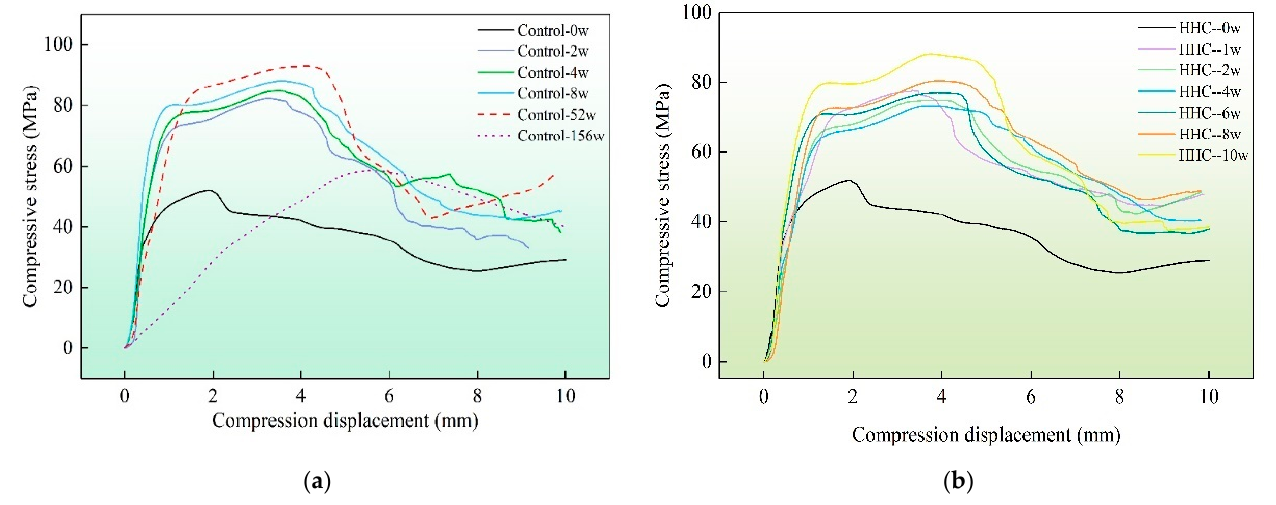
Figure 11. Stress-strain curve during humidity heat ageing and natural ageing. ( a ) Stress-strain curves during storage of control group samples. ( b ) Stress-strain curves during storage of treatment group samples.